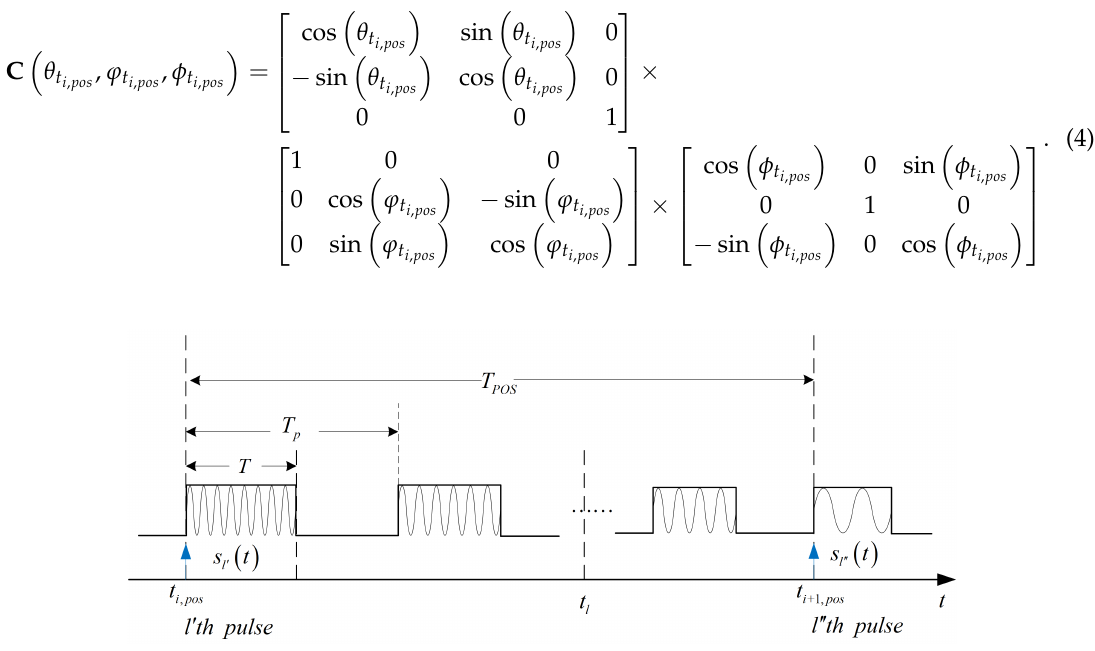
Figure 3. Pulse and POS data timing